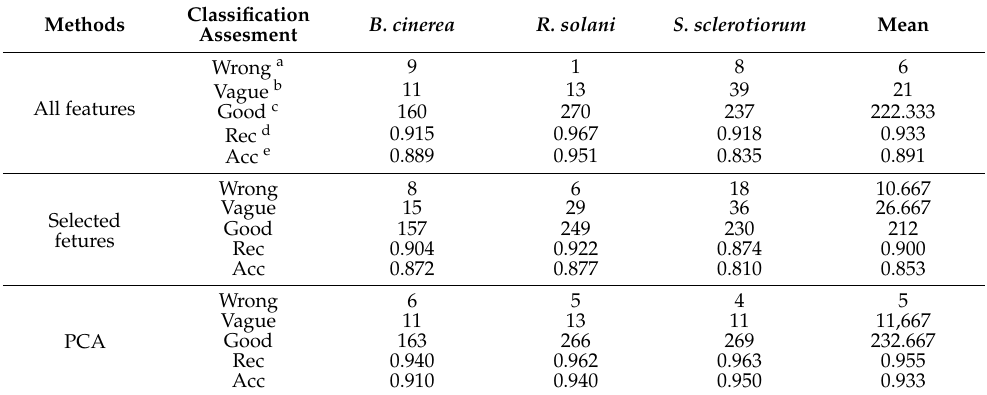
Table 2. Reliability of distinguishing three species of fungi on the basis of hyperspectral